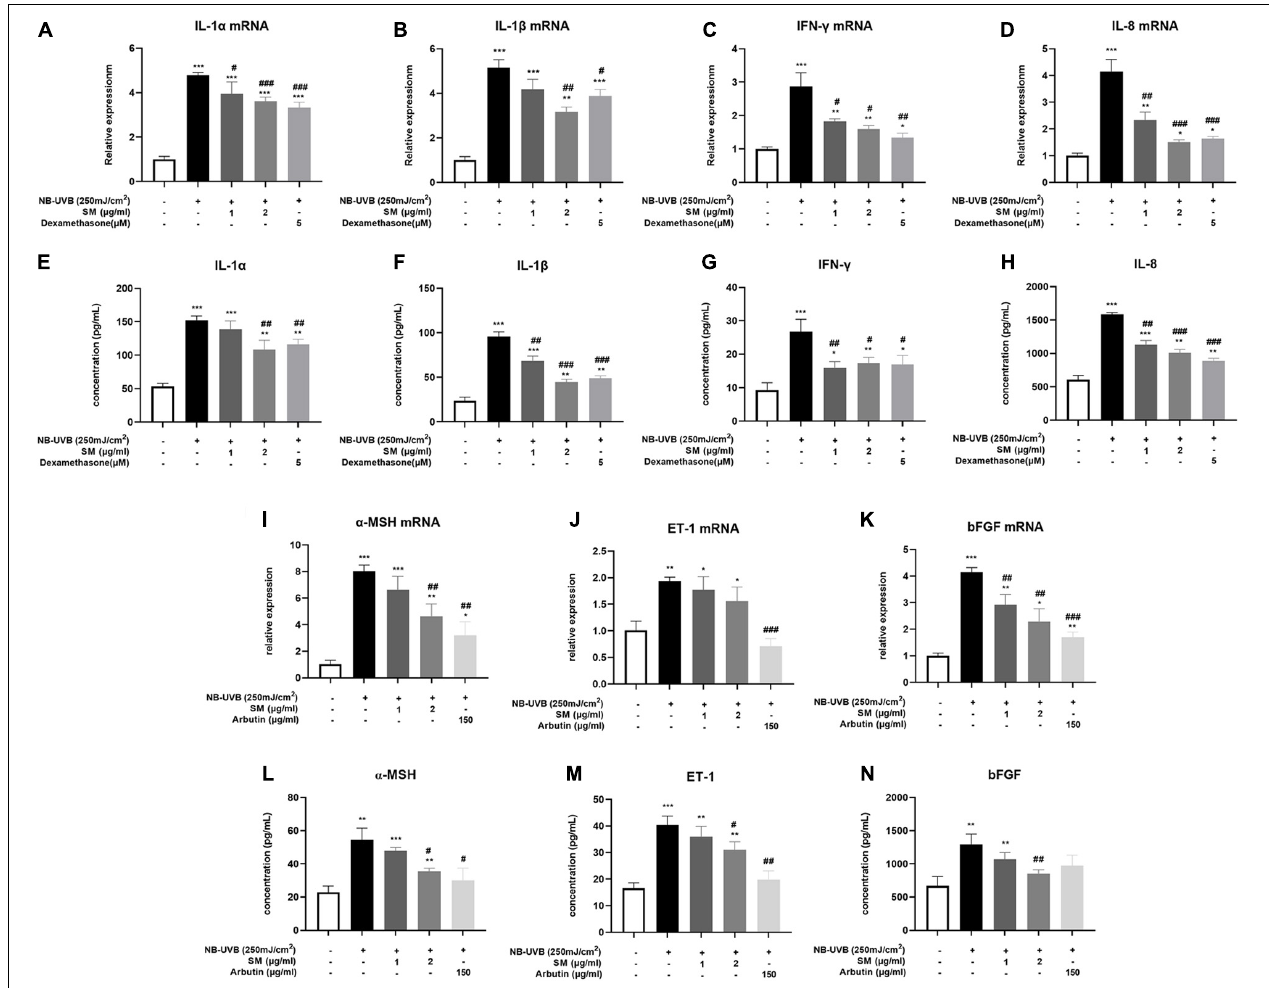
FIGURE 2 | Solamargine (SM) attenuated UVB-induced secretion of pro-inflammatory cytokines and melanogenic factors in HaCaT cells. Real-time PCR (24 h after incubation with SM) and ELISA assay (48 h after incubation with SM) demonstrated SM attenuated UVB-induced secretion of pro-inflammatory cytokines, IL-1 α (A,E) , IL-1 β (B,F) , IL-8 (C,G) , and IFN- γ (D,H) in HaCaT cells. Treatment with SM after UVB irradiation significantly decreased the mRNA and protein levels of IL-1 α , IL-1 β , IL-8, and IFN- γ . The anti-inflammatory effect of SM is comparable to 150 µ g/ml dexamethasone. Real-time PCR and ELISA assay demonstrated